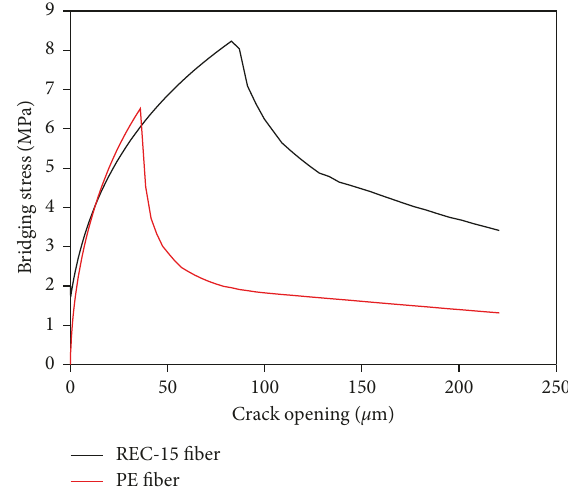
Figure 8: Computed fiber bridging stress-crack opening re- lationship ( σ δ ) of ECC with REC-15 fiber and PE fiber. −